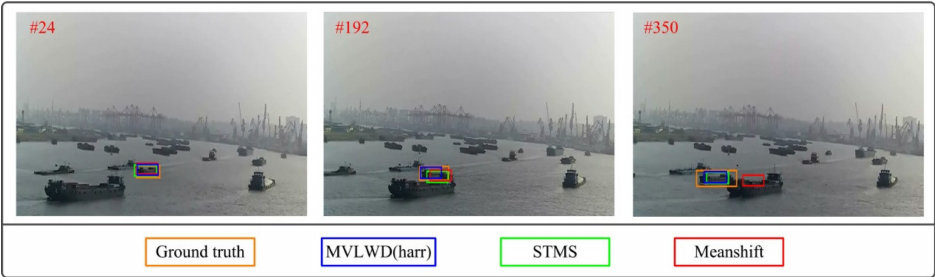
Figure 5. Euclidean distance distribution for the three trackers for video #2.